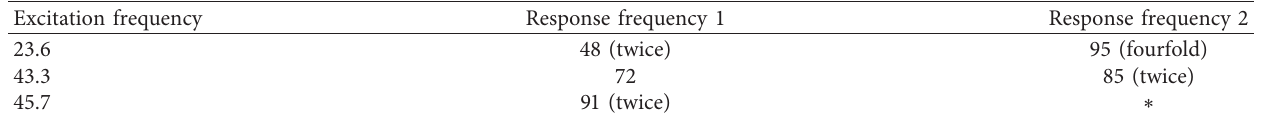
Figure 15: Standard deviation of the wire rope vibration at different excitation frequencies. (a) Transverse. (b) Longitudinal. Table 3: Main response frequency of the transverse rope vibration under different excitation